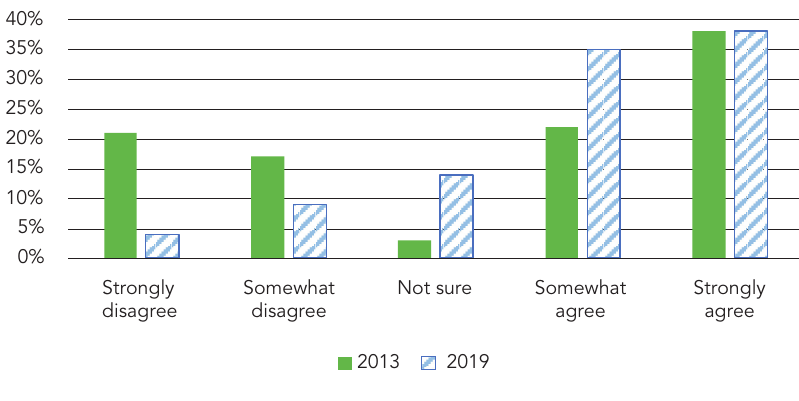
Chart 4: Attitudes: Rate whether you agree or disagree with the statement ‘Human population growth is driving other animal species to extinction’.